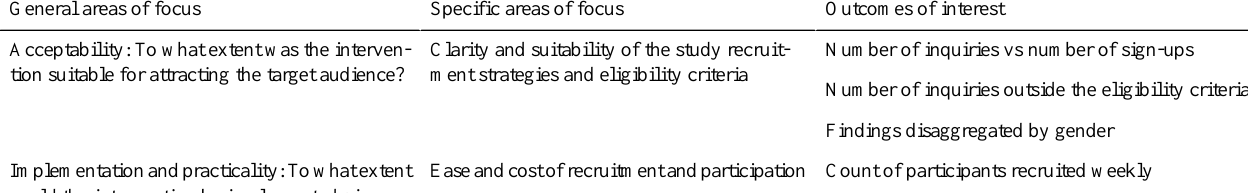
Outcomes of interestSpecific areas of focusGeneral areas of